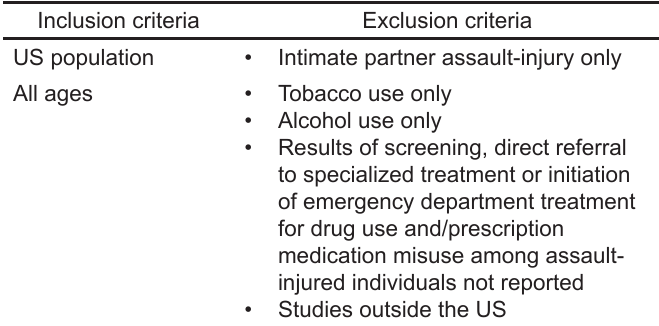
Table. Study eligibility